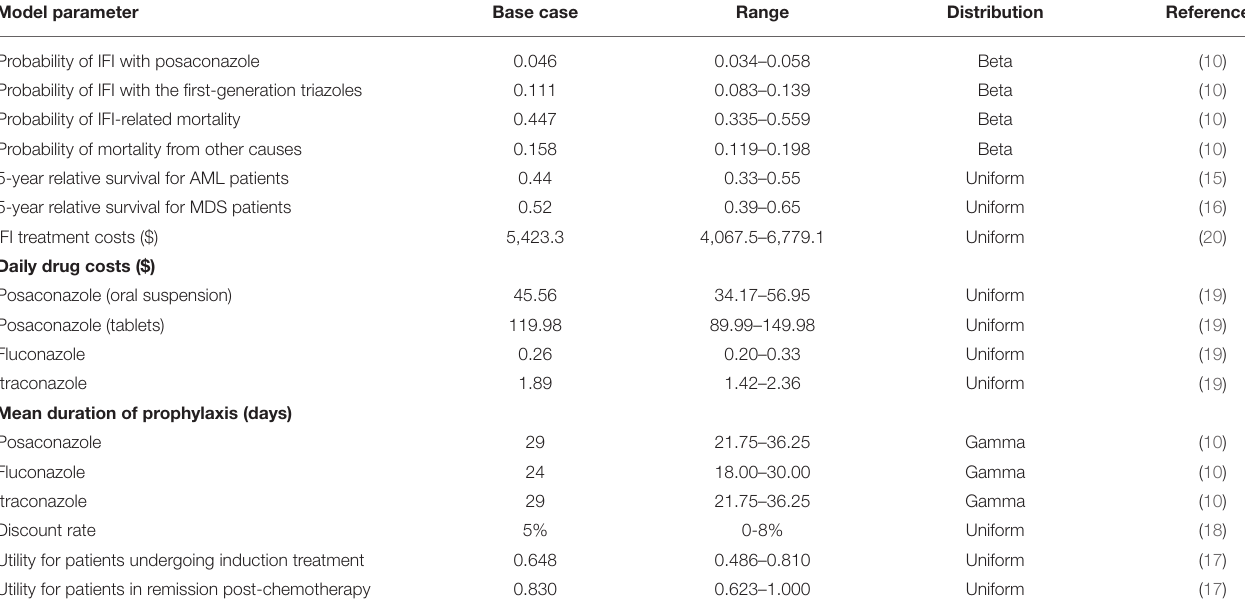
TABLE 1 | Input parameters for model